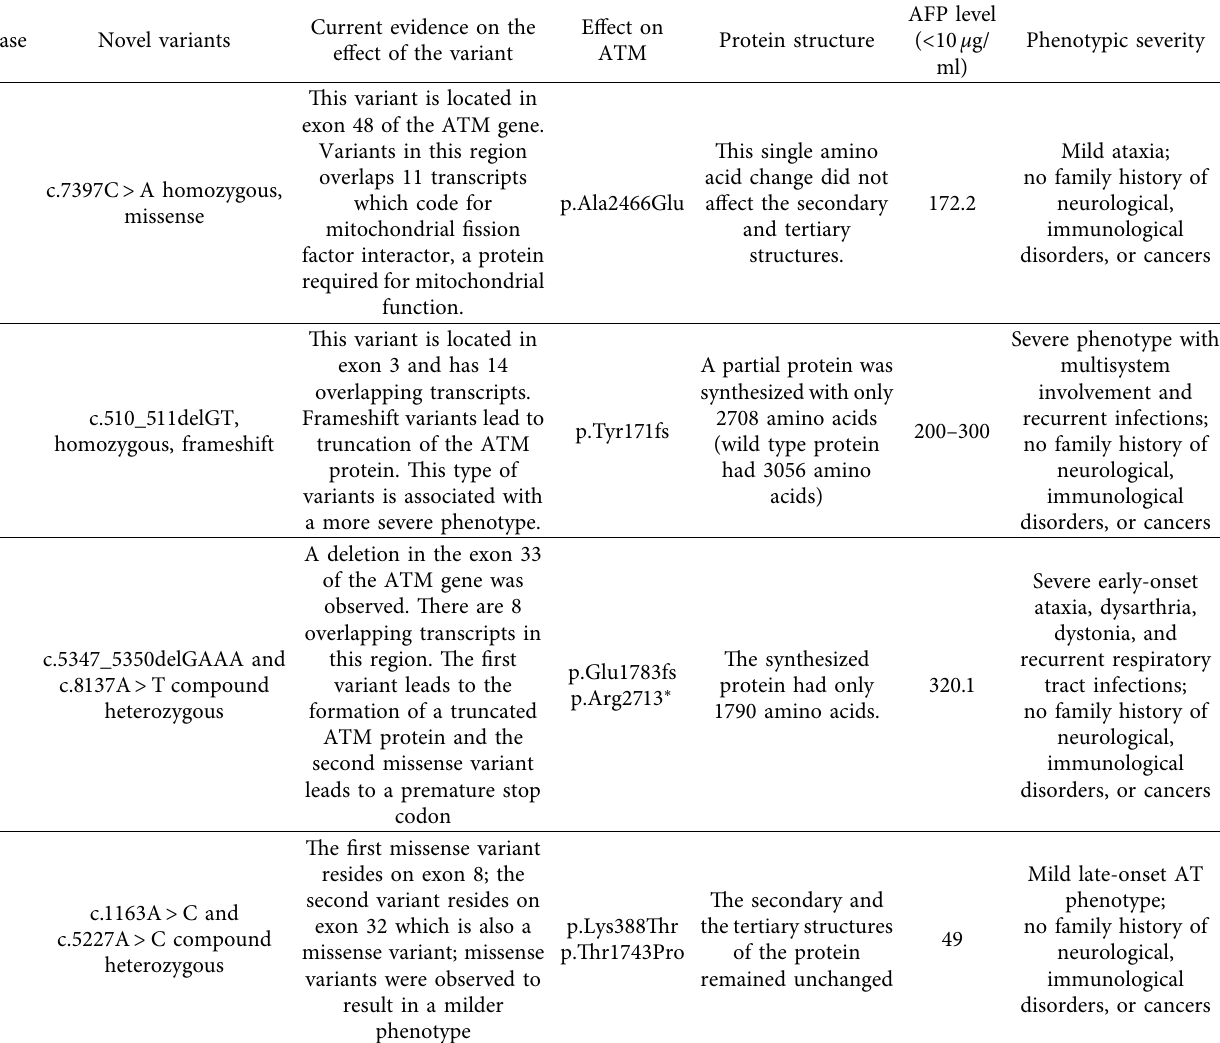
Table 1: Comparison of mutation positions of the cases and its effect on protein sequence and phenotypic